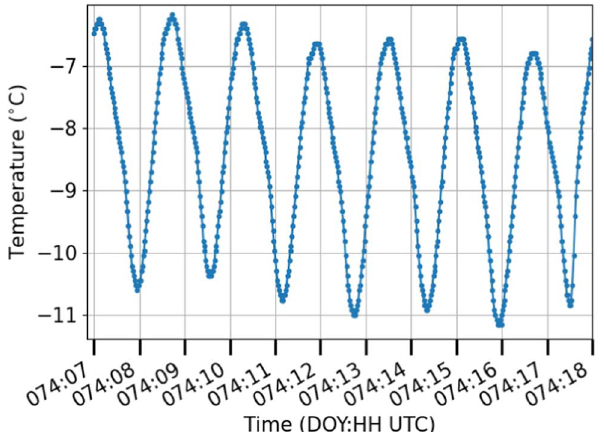
Figure 10. A typical CCD temperature pro fi le over several CUTE orbits.